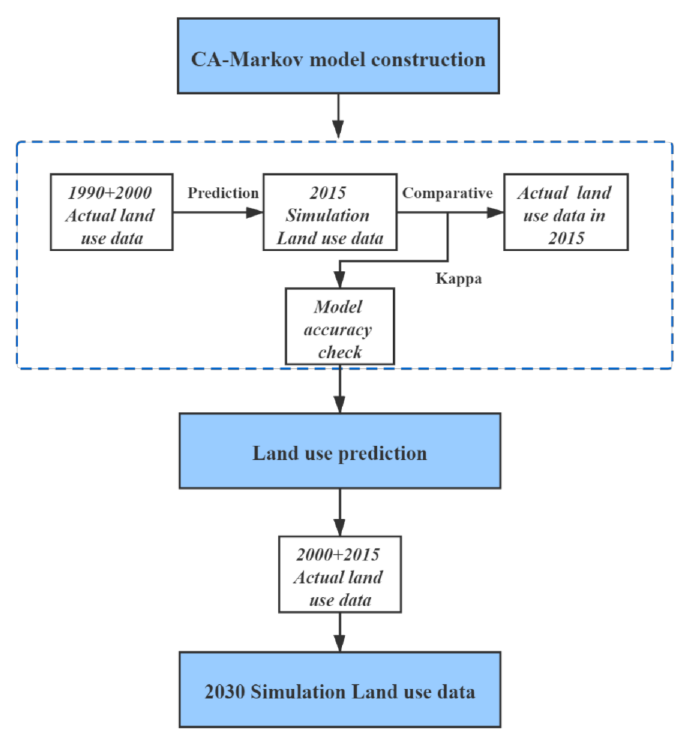
Figure 2. Flow chart showing primary steps in the simulation